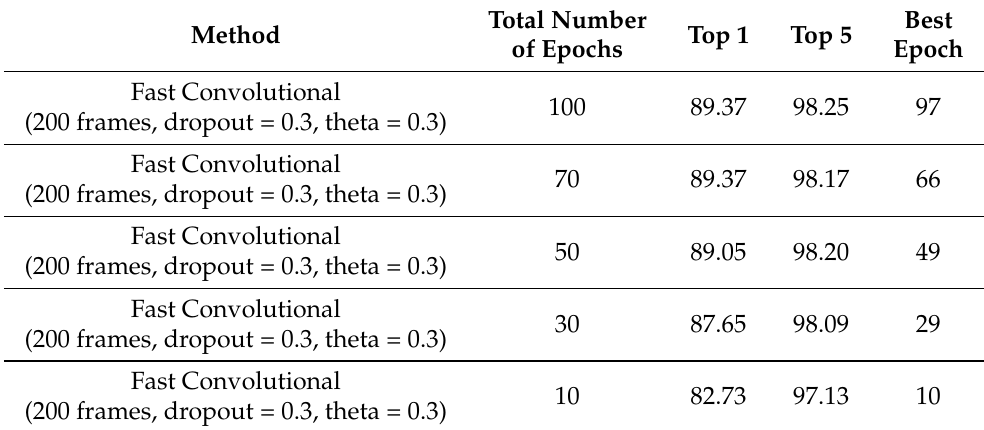
Table 8. Performances achieved by the proposed model for the Cross-Subject protocol (v1—60) depending on the number of epochs set for training.